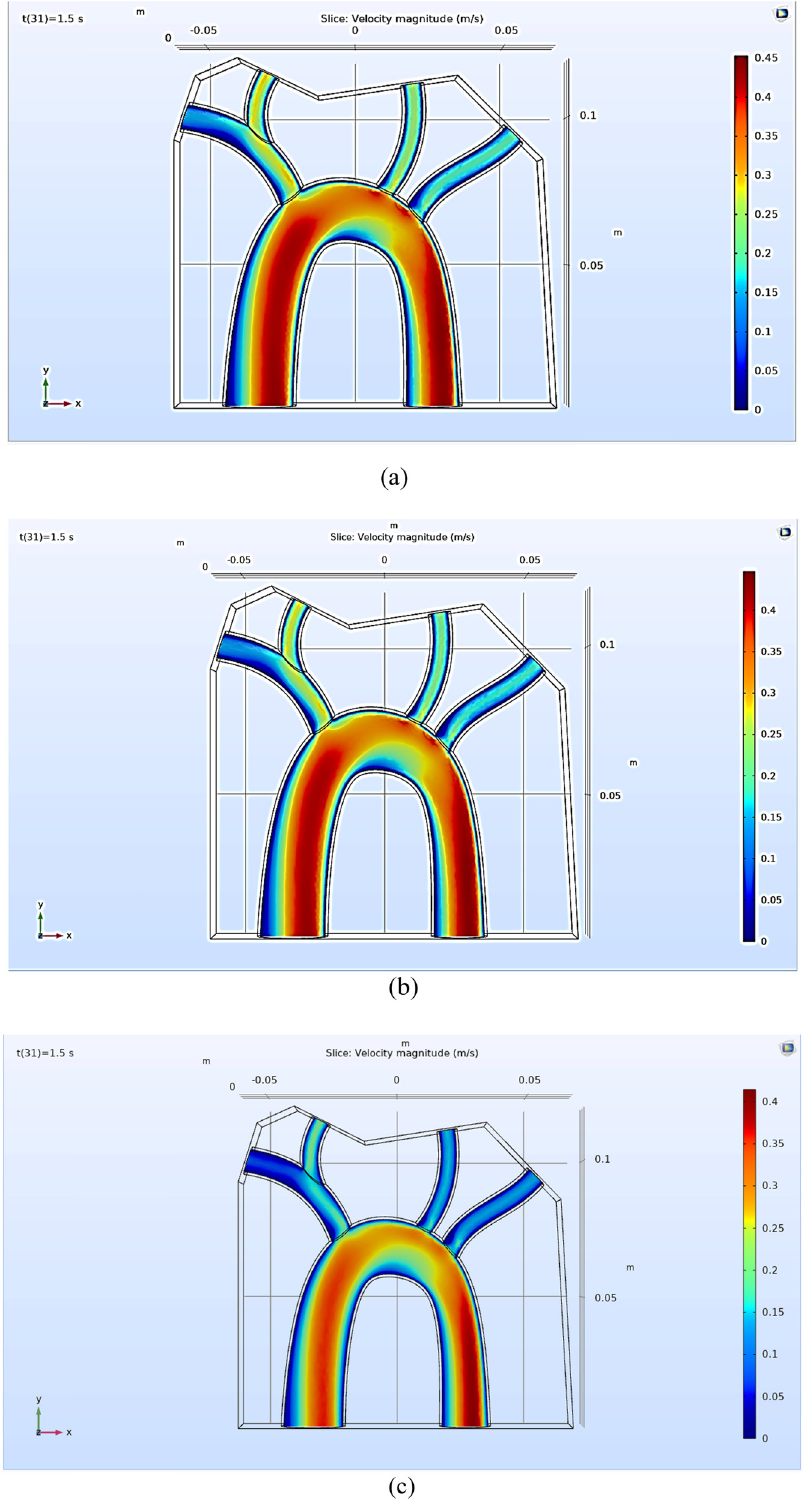
Figure 4: Velocity contour ( a ) 0.005, ( b ) 0.01, ( c ) 0.02, ( d ) 0.03, ( e ) 0.04, ( f ) 0.05, ( g ) 0.06, ( h ) 0.07, ( i ) 0.08, ( j ) 0.09, ( k ) 0.1, all in